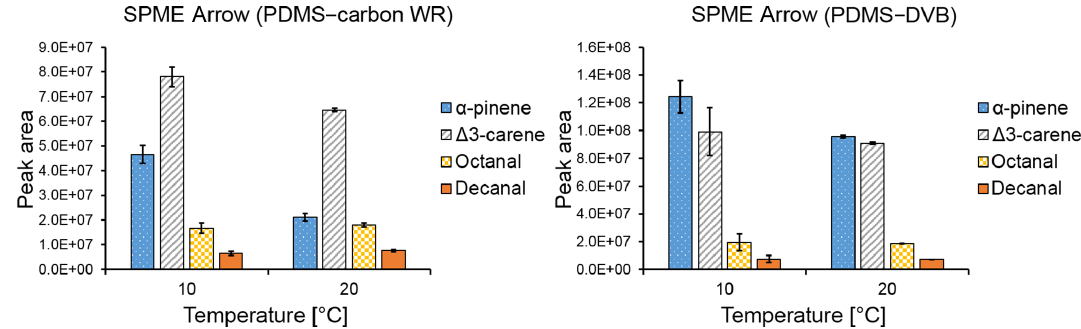
Figure 4. Effect of temperature ( ◦ C) on the extraction efficiencies obtained with SPME Arrow using PDMS–carbon WR and PDMS–DVB sorbents.